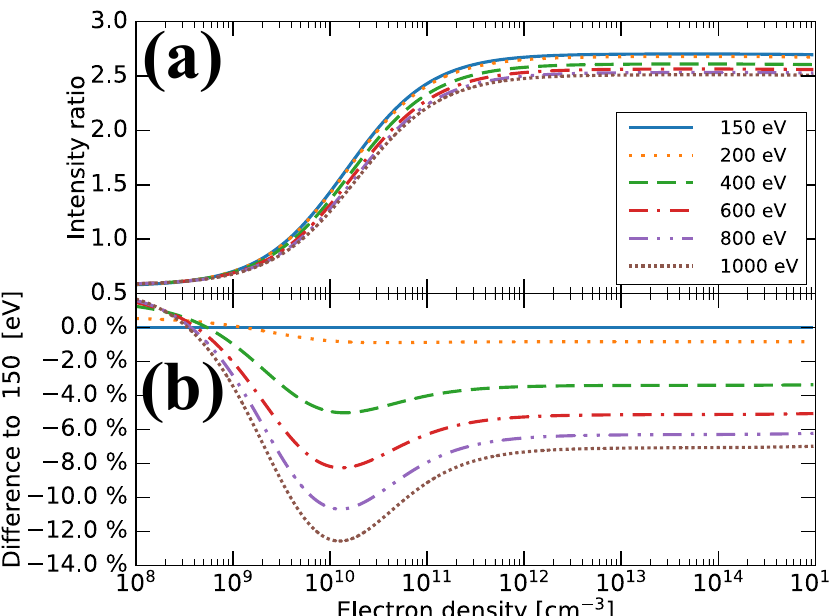
Figure 3. ( a ) Electron density dependence of Fe XIV 264.785 Å/274.203 Å intensity ratio for various temperatures the IoEx0p0 model. ( b ) Difference in intensity ratio relative to case of 150 eV at each temperature.